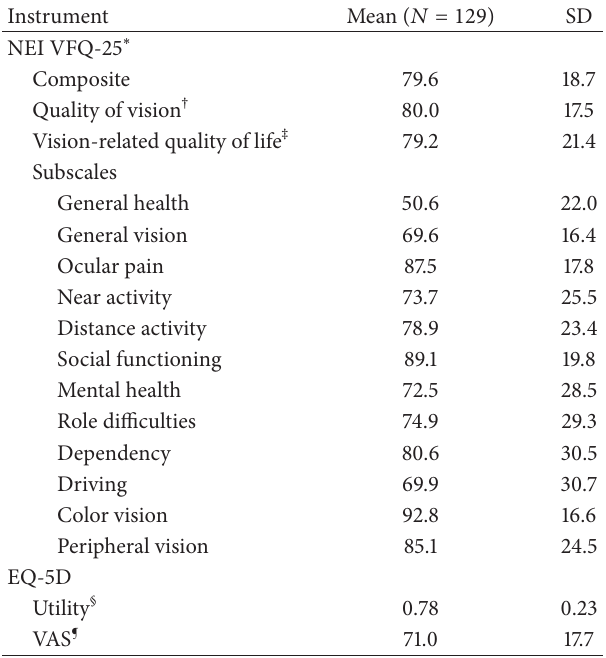
Table 4: Mean NEI VFQ-25 and EQ-5D scores at 6 months for all patients.